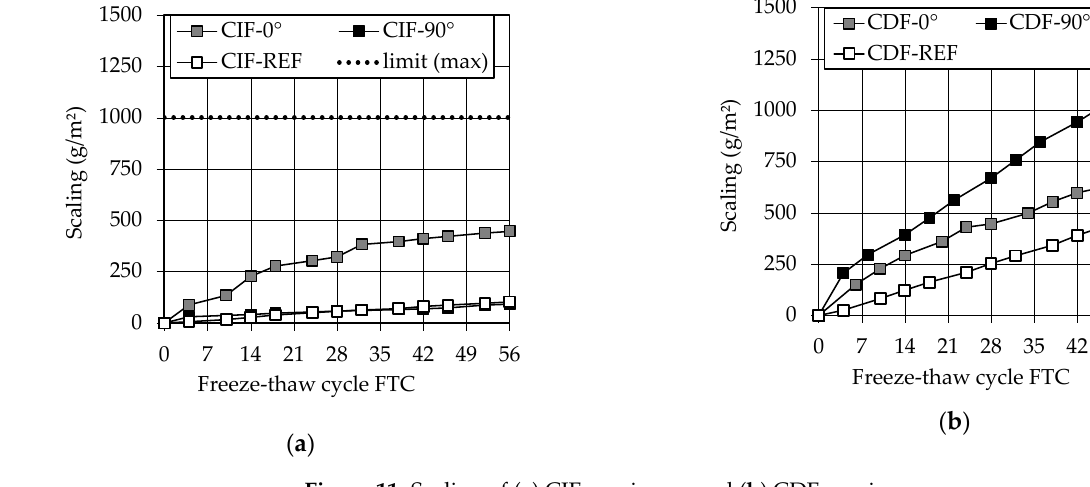
can be made about a real anisotropy of the results. TAC of the specimens ranging from 4.0 vol % to 5.6 vol %, since a w/c ratio of 0.55, 0.50, and 0.45, respectively, and a minimum TAC of 4.0 vol % are required for exposure classes XF2, XF3, and XF4 according to EN 206:2013+A1:2016 [55]. The good results of the scaling during the freeze–thaw tests and the assumption of a dense pore structure combined with a sufficient TAC can be confirmed by the low water absorption during the pre-storage and the freeze–thaw cycles, see Figure 12a,b of maxi- mum 0.6 wt %.